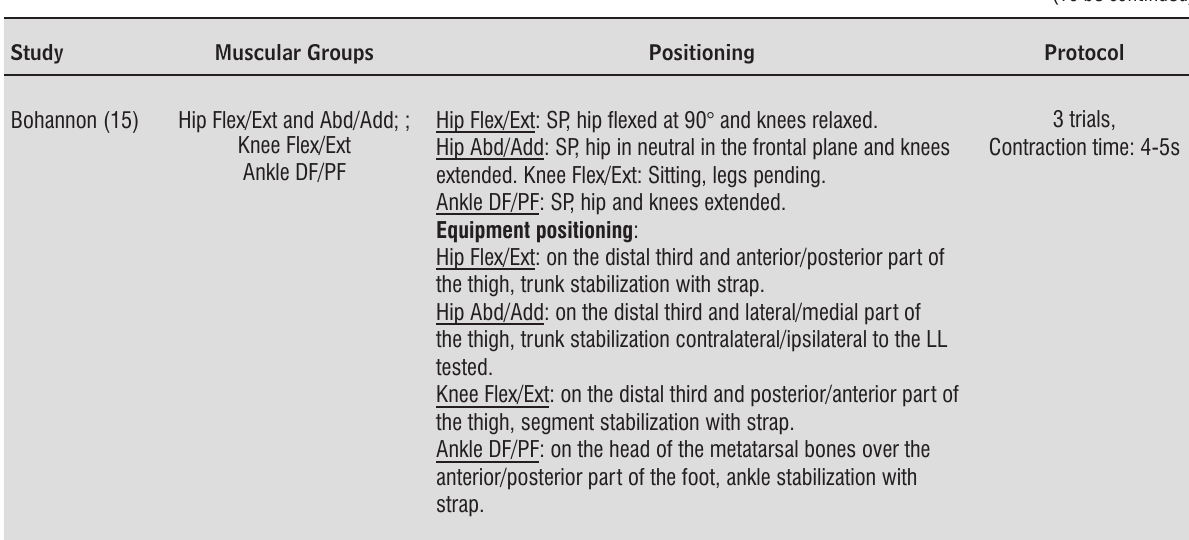
Table 2 - Data extraction of the 30 studies, which assessed the strength of the lower limb muscles with portable dynamometry in subjects with stroke and provided information regarding the positioning or the data